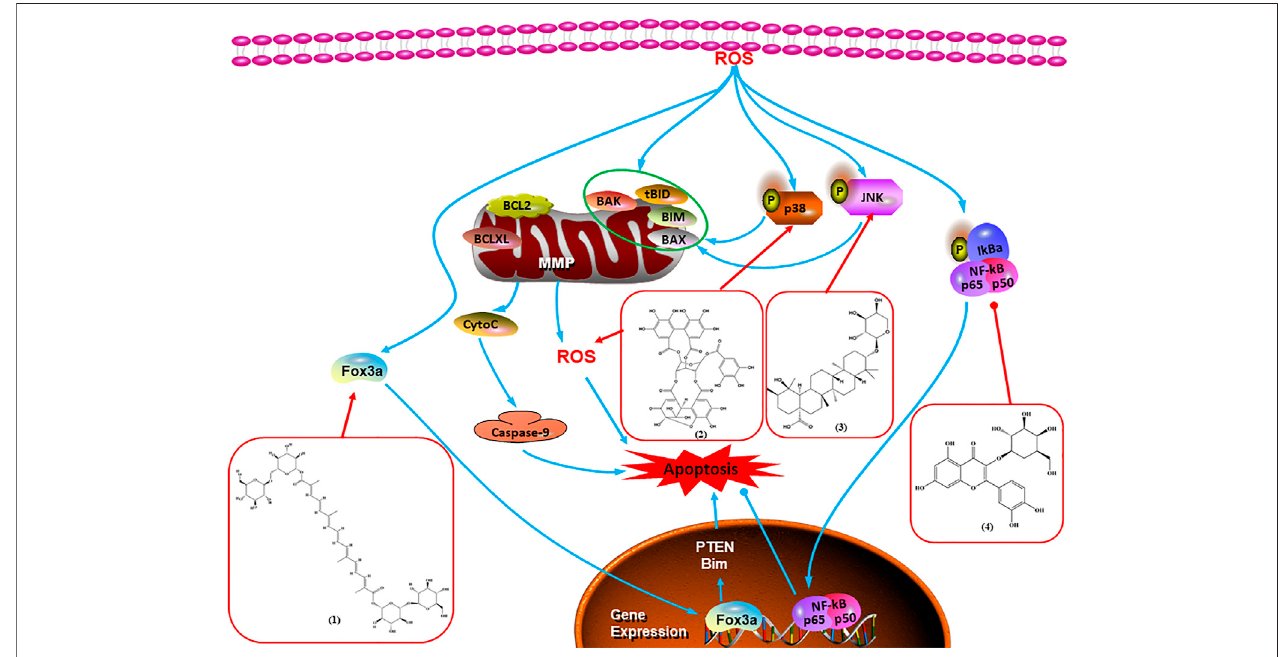
FIGURE 5 | Natural products induced apoptosis through ROS pathway. (1) Crocin, (2) geraniin, (3) ziyuglycoside II, (4)